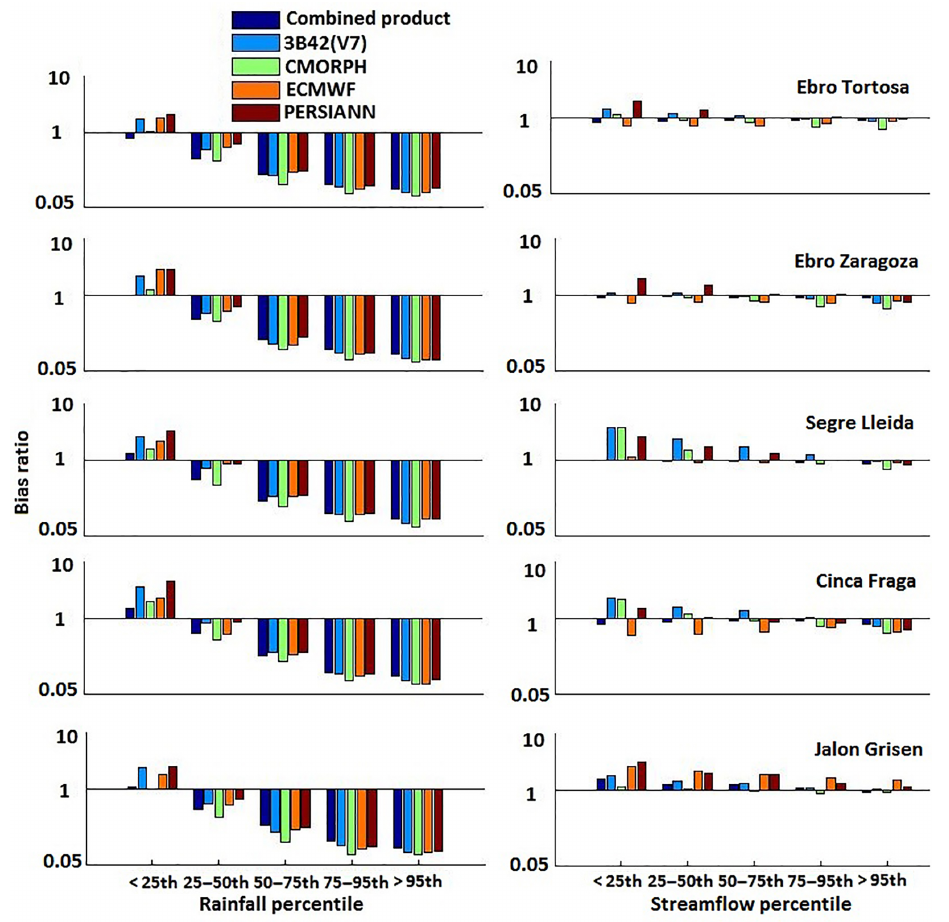
Figure 13. Bias ratio of precipitation and